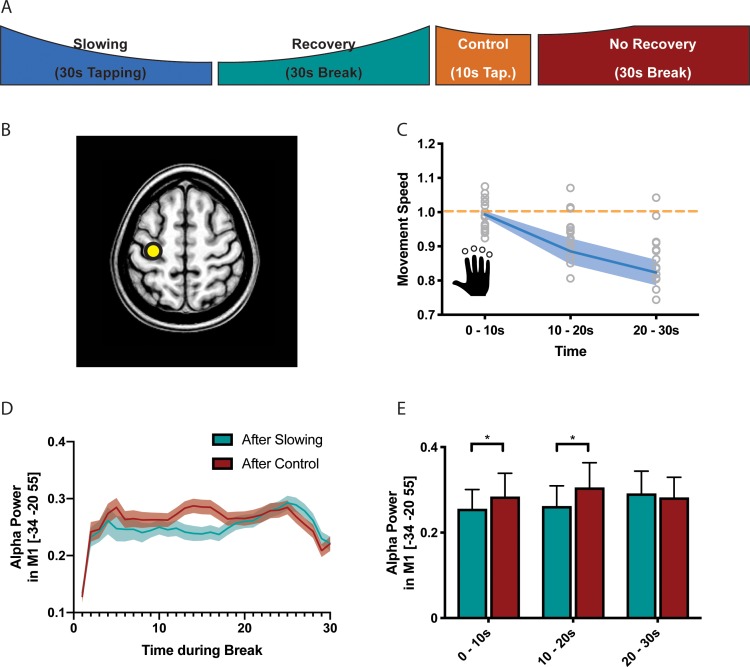
Results of the electroencephalography (EEG) experiment (N = 17).(A) Participants performed slowing (30 s) or control (10 s) sequence tapping followed by a break of 30 s while EEG was measured. (B) Source localisation was performed using eLoreta and fluctuations of alpha power extracted from primary sensorimotor cortex (SM1). (C) Motor slowing during the behavioural task (blue line) normalised to control condition (orange line). (D) Power over time during breaks after tapping (green = break after slowing tapping, red = break after control tapping, dotted lines = sem.). (E) Same as (D), binned in 10 s blocks for statistical analysis. All values mean ± sem. *p<0.05.10.7554/eLife.46750.019Figure 5—source data 1.Individual behavioural data (movement cycles per time bin) of the EEG experiment depicted in panel 5C.All values normalised to control condition.10.7554/eLife.46750.020Figure 5—source data 2.Individual alpha power data depicted in panel 5E.